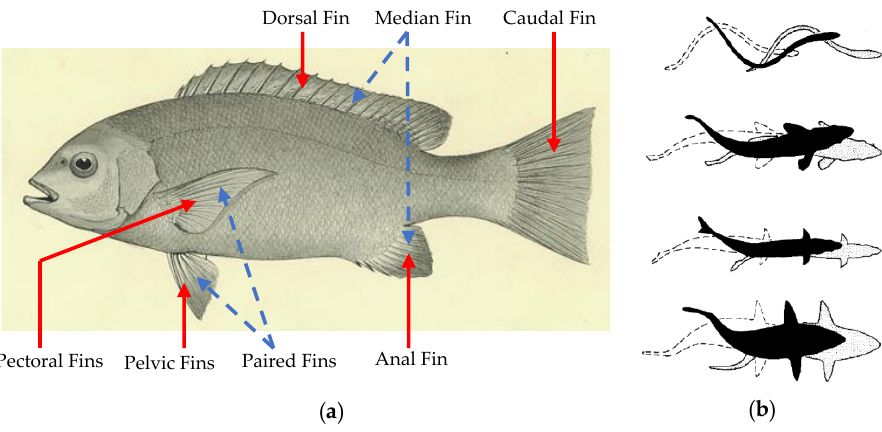
Figure 7. Fish locomotion: ( a ) Main parts of a fish that involves locomotion; ( b ) BCF motion of 4 different types of fish families [110].